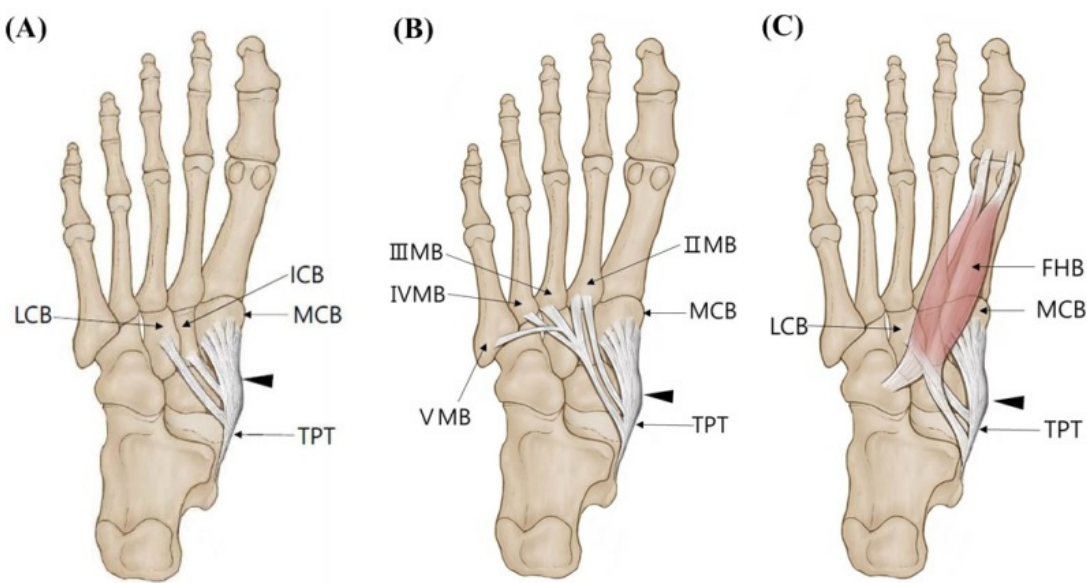
Figure 3. Schematic drawing of the Type 3 tibialis posterior tendon insertion. Black-colored arrow indicates TPT inserts to